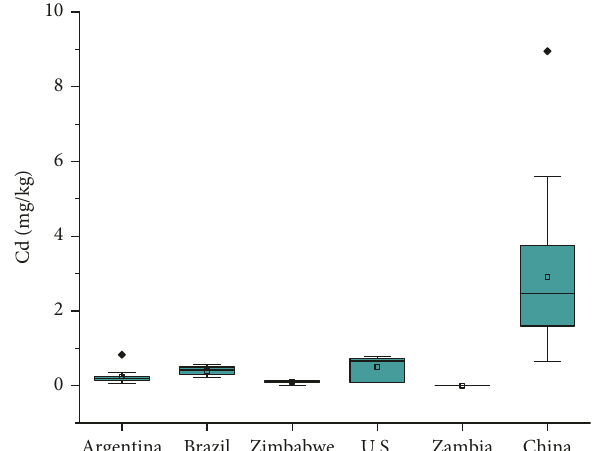
Figure 8: The box plots of Cd content in tobacco leaf from different countries in tobacco leaf from different countries.